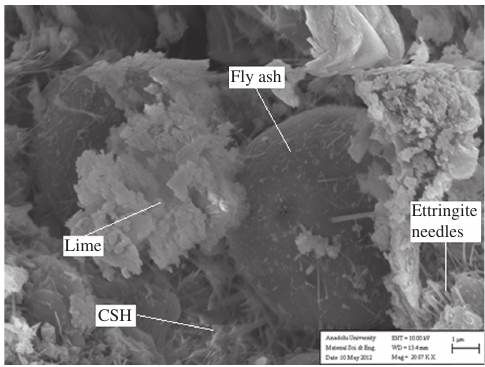
Figure 10 Secondary electron image of CSH formation.